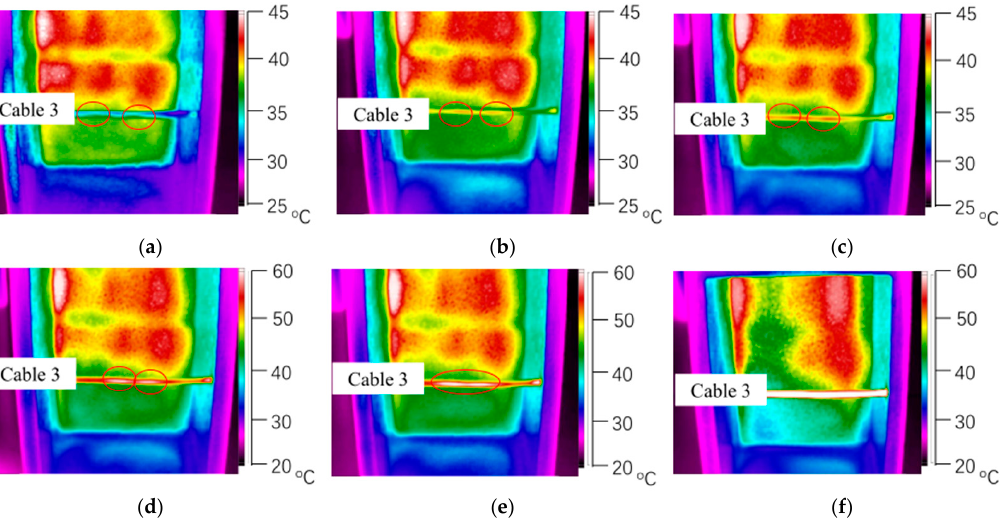
Figure 7. Surface temperature distribution of the Group #2 cables at different times during the heating phase (the defect is on the back of the cable). ( a ) Heating up for 20 s. ( b ) Heating up for 40 s. ( c ) Heating up for 60 s. ( d ) Heating up for 80 s. ( e ) Heating up for 100 s. ( f ) Heating up for 120 s.